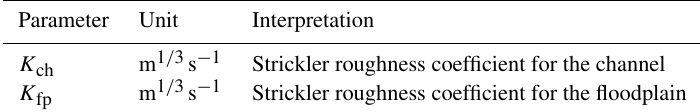
Table 1. Names, units and interpretations of the variables used in the geometric and hydraulic equations of the MHYST model. Variable Unit Interpretation H T m Threshold height V (H T ) m 3 Volume created by a height H T over a reach S(H T ) m 2 Flooded area created by a height H T over a reach A(H T ) m 2 Average cross section area created by a height H T over a reach B(H T ) m Average surface width created by a height H T over a reach Q(H T ) m 3 s − 1 Mean discharge created by a height H T over a reach m 3 s − 1 Conveyance capacity A ch m 2 Cross section area of the channel m 2 Cross section area of the floodplain m Hydraulic radius of the channel m Hydraulic radius of the floodplain mm − 1 Slope of the channel m Bankfull water level of the channel m Bankfull width of the channel m 2 Bankfull cross section area of the channel Q b m 3 s − 1 Bankfull discharge of the channel A D m 2 Drainage area upstream a given cell L m Target length of a reach (fixed) Table 2. Names, units and interpretations of the free parameters of MHYST’s structure. Parameter Unit Interpretation K ch m 1 / 3 s − 1 Strickler roughness coefficient for the channel K fp m 1 / 3 s − 1 Strickler roughness coefficient for the floodplain